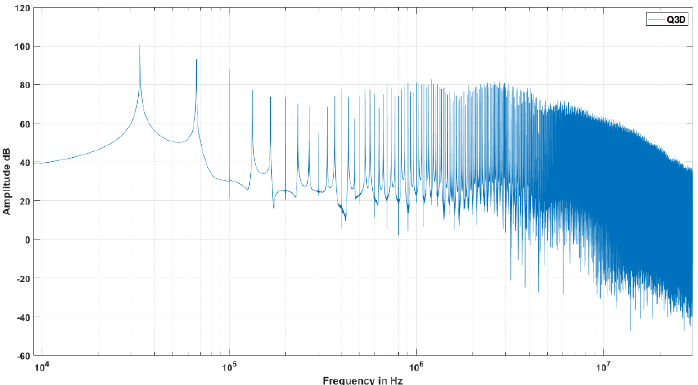
Figure 21. Conducted emission estimation using the Q3D approach. Frequency sweep 9 kHz to 30 MHz.